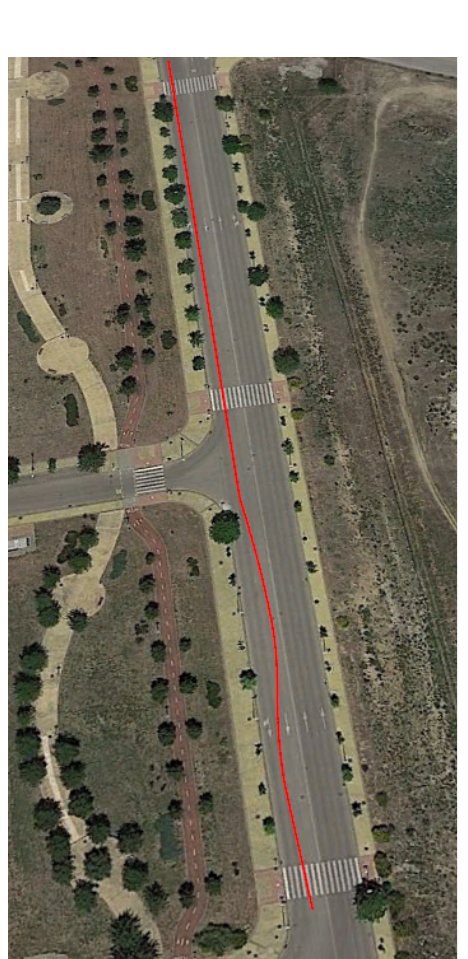
Figure 10. Test 2: Map and vehicle trajectory (Map scale 1:2100